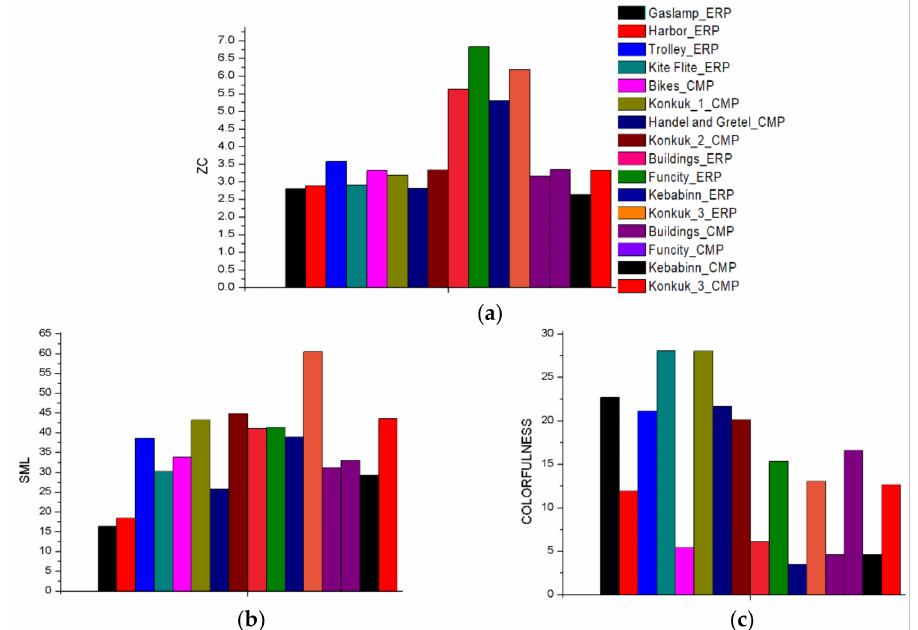
Figure 4. Attribute distribution of datasets: ( a ) ZC, ( b ) SML, and ( c ) colorfulness.